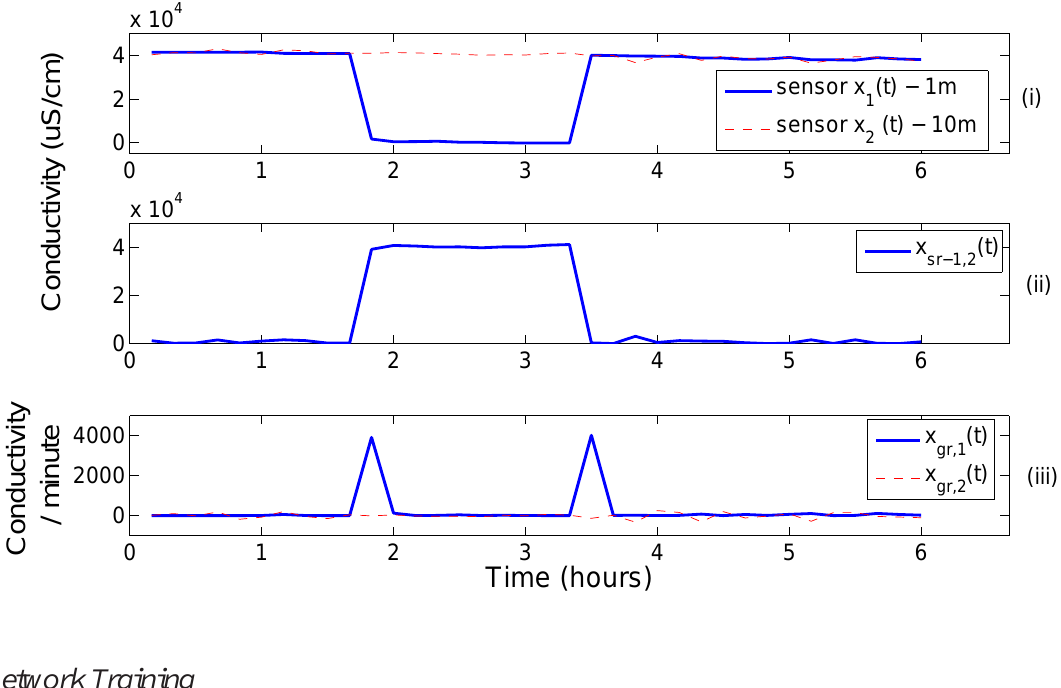
Figure 5. A comparison of the corresponding readings from co-situated conductivity sensors at 1 m ( x ( t ) ) and 10 m ( x ( t ) ). (i) The sensor x ( t ) had a step change in its readings as 1 2 1 a result of an electronic fault; (ii) The difference test ( x ( t ) ) between the sensors could sr identify the fault but can not resolve which of the sensors was responsible. The x was conditioned upon the gradient test x ( t ) shown in (iii) and previous class state q gr infer x ( t ) was 1